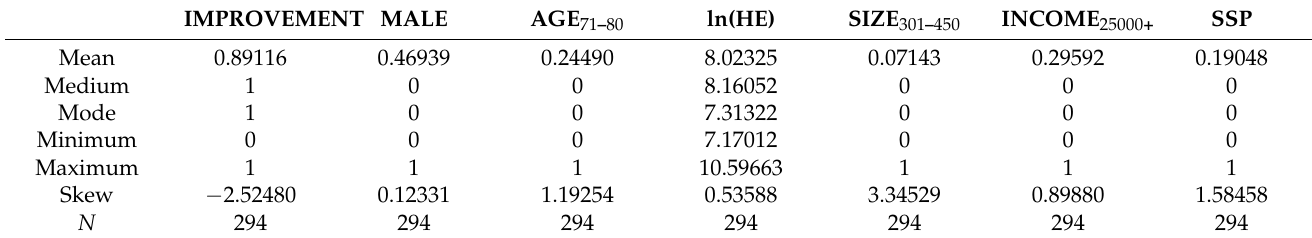
Table 2. Descriptive